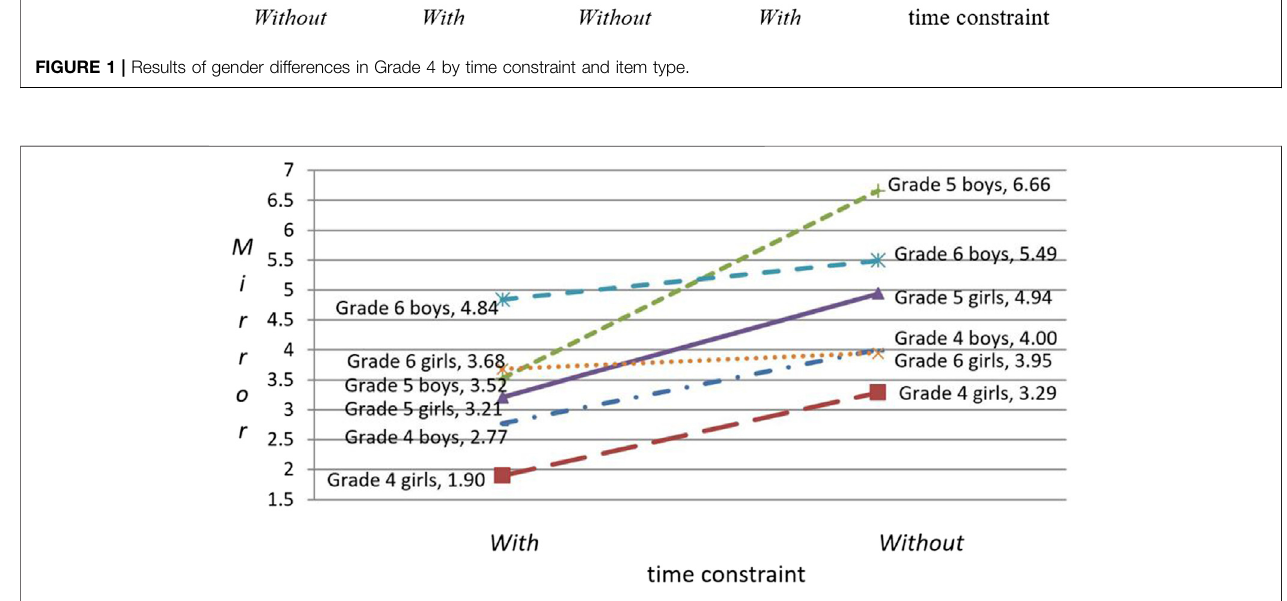
FIGURE 2 | Gender differences by time constraint and grade in Mirror item scores.